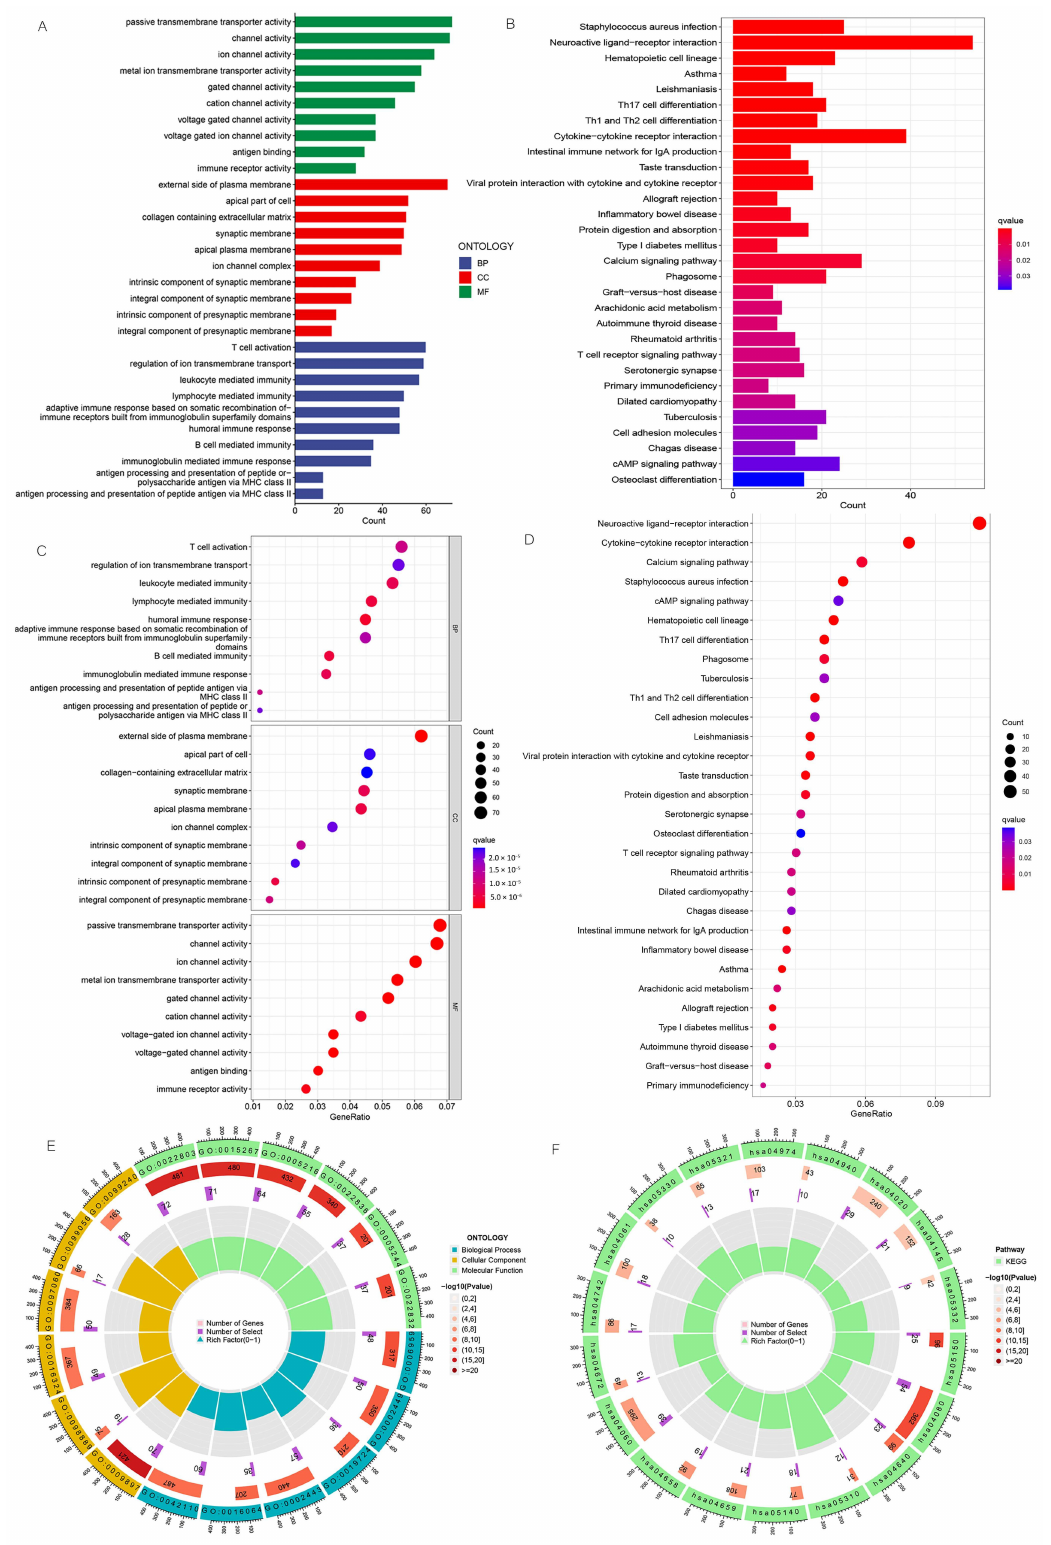
Figure 10. GO and KEGG pathway enrichment analyses. ( A ) Bar plot of the top 10 GO enrichment terms. ( B ) Bar plot of the top 30 KEGG enrichment terms. ( C ) Bubble chart of the top 10 GO enrichment terms. ( D ) Bubble chart of the top 30 KEGG enrichment terms. ( E ) Circle diagram of GO enrichment analysis. ( F ) Circle diagram of KEGG enrichment analysis. GO enrichment terms include biological process, cellular component, and molecular